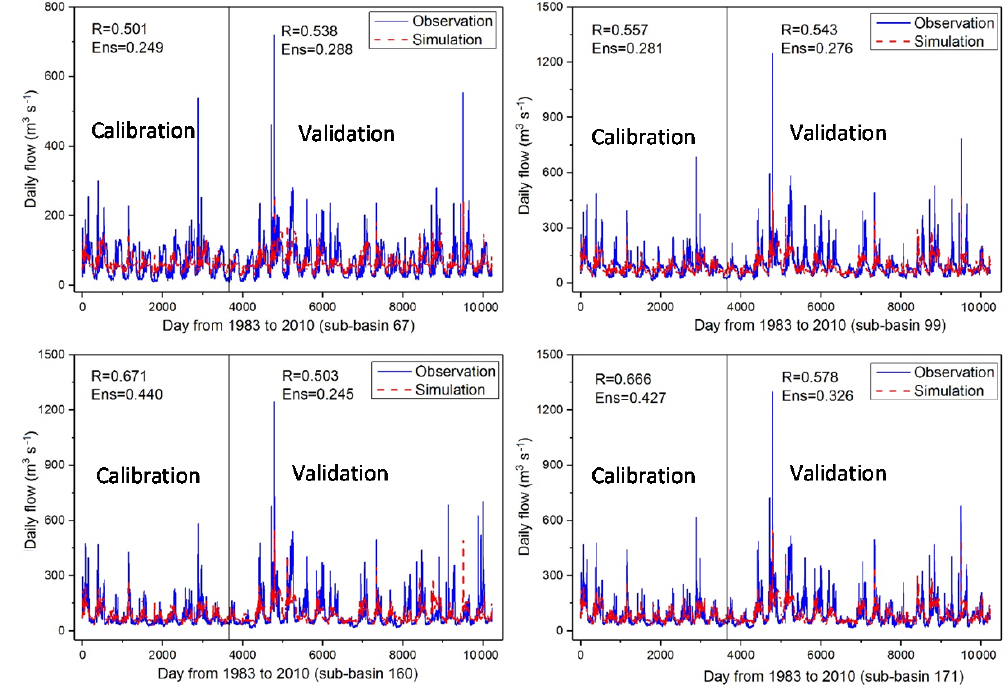
Figure 3. Calibration and validation results under the R1 scenario (default SWAT schemes for reservoir